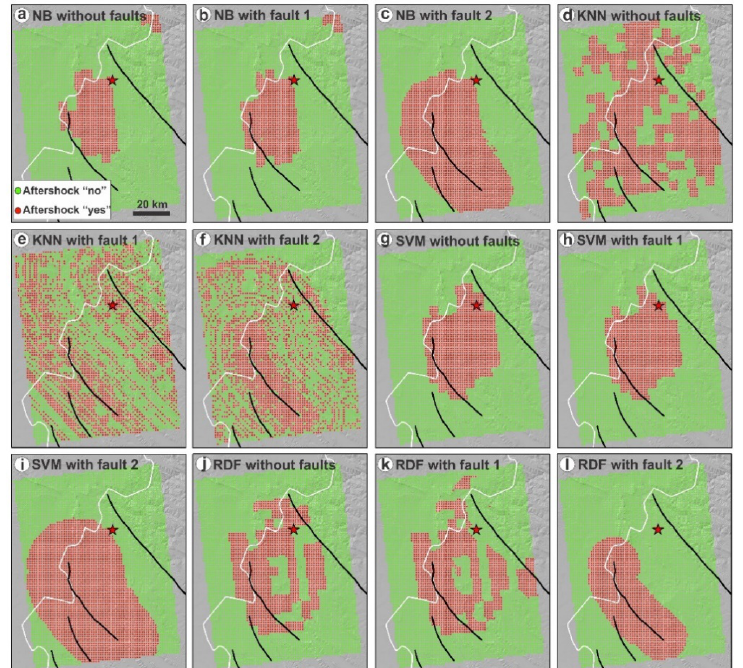
Figure 5. ( a – l ) Predicted aftershock patterns using di ff erent algorithms. The red star shows the location of the main shock. The small red dots are the aftershocks predicted by each classifier. The black lines delineate recognized